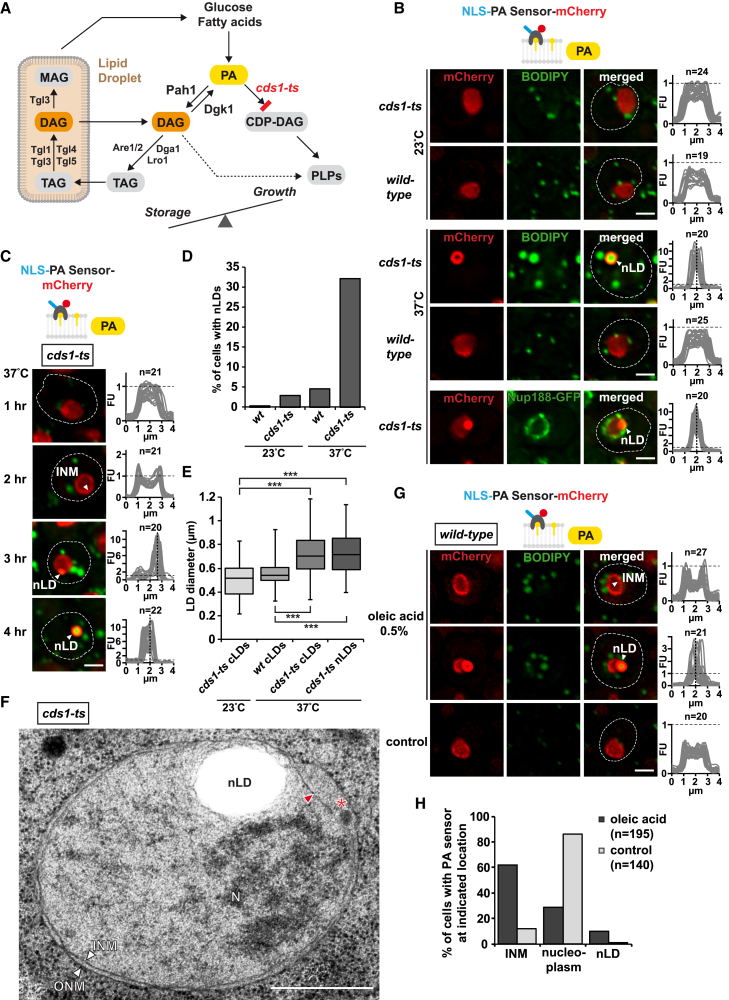
Cds1 and Nutrients Regulate Nuclear Lipid Droplet Synthesis at the INM(A) Cartoon depicts a shift toward the storage branch of lipid metabolism (Henry et al., 2012) through Cds1 inactivation (cds1-ts). TAG (triacylglycerol) is stored in lipid droplets, which are metabolized by specific enzymes. MAG, monoacylglycerol; other abbreviations are as in Figure 1A.(B) Live imaging of wild-type or cds1-ts cells expressing the NLS-PA-mCherry sensor grown at the indicated temperatures for 4 hr. BODIPY stains lipid droplets; Nup188-GFP visualizes nuclear pores. Sensor fluorescent intensity was quantified across the nucleus as in Figure 1. The line scan was centered on nuclear lipid droplets (nLD) when present (dashed vertical line). Scale bar, 2 μm.(C) Time course of nLD formation in cds1-ts cells expressing NLS-PA-mCherry sensor. Exponentially growing cells were shifted from 23°C to 37°C and examined at the indicated time points. See also Videos S1 and S2. Scale bar, 2 μm.(D) Quantification of cells with nLDs. Cells were grown for 4 hr at the indicated temperatures. nLDs were defined as spherical structures that stained both with BODIPY and NLS-PA-mCherry sensor. At least 200 cells were counted for each condition.(E) Comparison of nuclear and cytoplasmic lipid droplet diameter in cells grown at the indicated temperatures. Box-whisker plot showing median, interquartile range, and minimum and maximum value. ∗∗∗p value <0.001 determined by ANOVA with post hoc Tukey HSD.(F) Transmission electron microscopy (TEM) of a representative cds1-ts cell after growth at 37°C for 4 hr. An nLD localizes next to the INM. The lumen of the NE is widened in a discrete portion (red arrowhead) and contains electron-dense material (red asterisk). Abbreviations are as before. Scale bar, 0.5 μm.(G) Live imaging of wild-type cells grown in oleic-acid-containing or control media, expressing the NLS-PA-mCherry sensor and stained with BODIPY. Two representative phenotypes of oleic-acid-treated cells are shown. Fluorescent intensity was quantified across the nucleus as in (B). Scale bar, 2 μm.(H) Quantification of NLS-PA sensor localization as observed in (G). n = number of analyzed cells.See also Figure S4 and Videos S1 and S2.